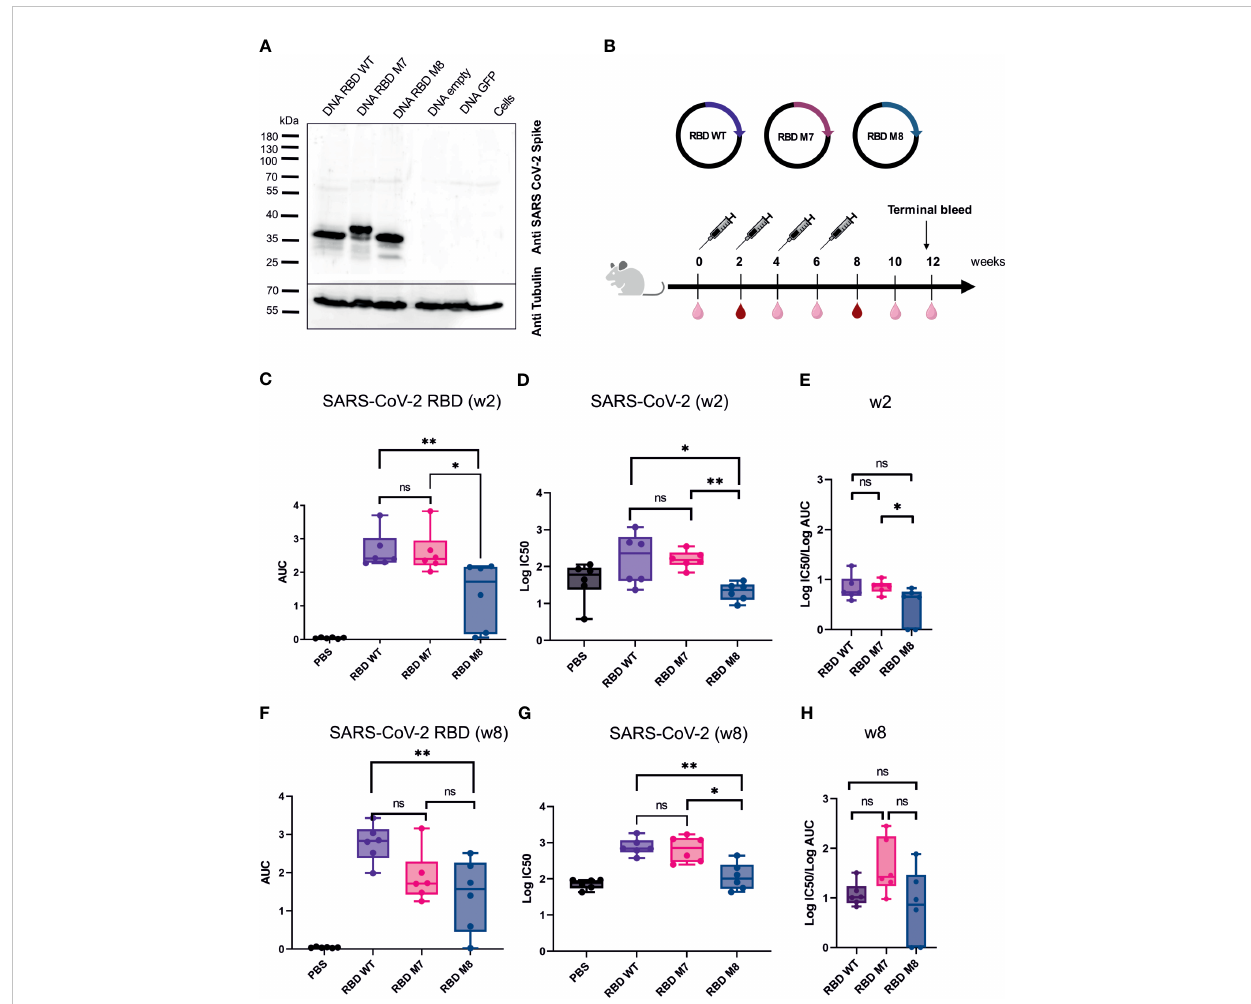
FIGURE 2 SARS CoV-2 RBD DNA-based vaccine candidates induce humoral immune response in Balb/c mice. (A) Expression analysis of DNA based vaccine candidates encoding glycan engineered SARS CoV-2 RBD mutants by Western blot of transfected HEK293T cells harvested after 48 h. Size in kilodaltons (kDa) and size of the molecular weight marker are indicated. The “ DNA empty ” lane refers to cells transfected with the same vector but missing the gene insert, the “ Cells ” lane represents untransfected cells. (B) Immunization schedule of BALB/c mice (n=6) vaccinated four times with DNA-based vaccines encoding SARS CoV-2 RBD WT, M7 and M8, respectively. Bleeds were taken at two-week intervals (light right symbol) and bleeds at week 2 and 8 (dark red symbol) were anlaysed for humoral repsonse. Binding antibody titers (C) represented as area under the curve (AUC) and neutralizing antibodies (D) shown as logIC50 values against SARS CoV-2 two weeks after the fi rst DNA immuniztation. (E) Ratio of log IC50 and log (AUC) was calculated to capture the proportion of neutralising antibodies to binding antibodies 2 weeks after the fi rst DNA immunization. Binding (F) and neutralizing antibodies (G) induced after 4 immunisations with the respective SARS CoV-2 RBD DNA vaccine candidate. (H) Calculated ratio of log IC50 and log(AUC) at week 8 after 4 DNA immunizations. The Mann-Whitney statistical test was applied (*p < 0.05; **p < 0.005 as asteriks or ns for non-signi fi